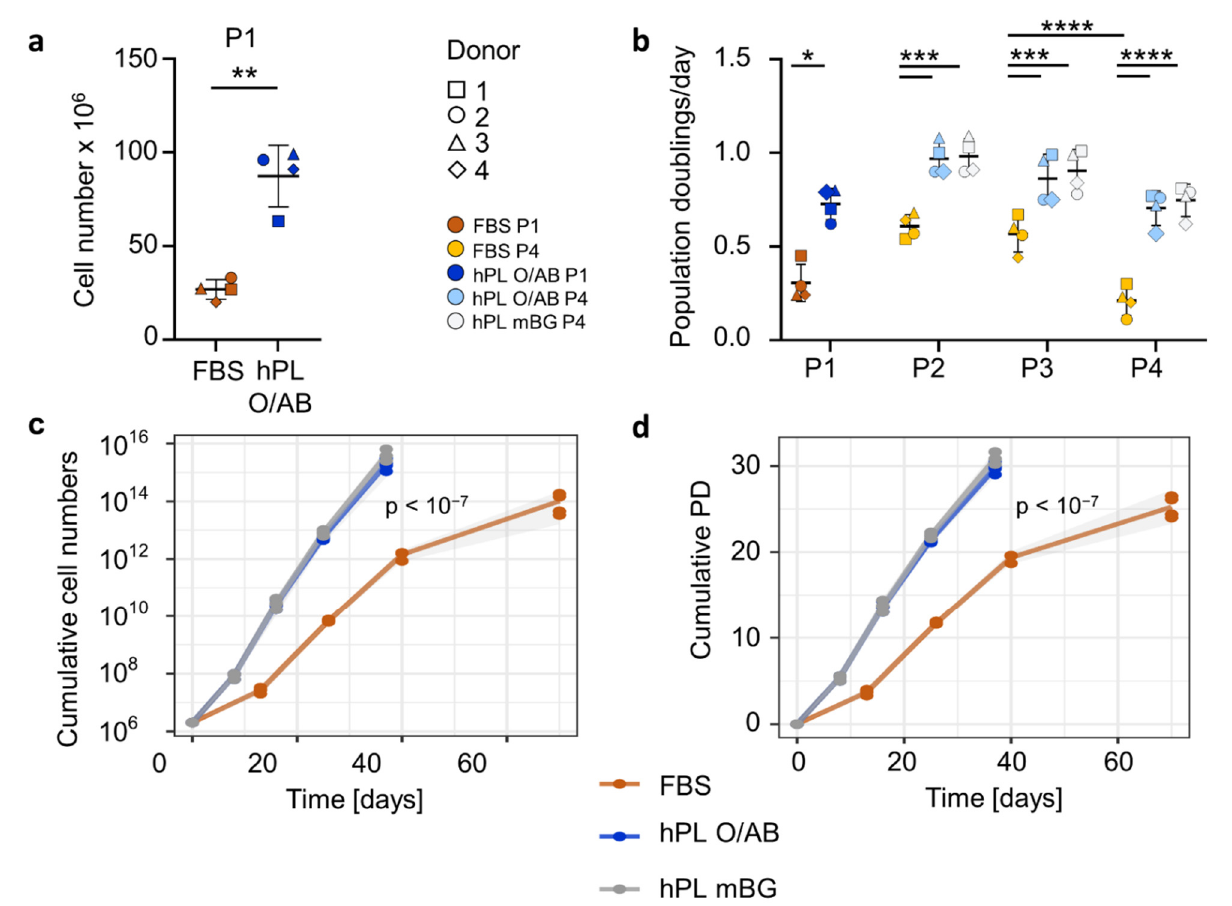
Figure A3. Large-scale extended propagation of BMSCs ( a ) Absolute number of BMSCs (donor 1–4, as indicated) cultured for one passage (P1) either with FBS or hPL O/AB. Paired t-test, ** p < 0.01. ( b ) Calculated population doublings per day of P1–P4 of BMSCs propagated in media containing FBS, hPL O/AB or hPL mBG. Repeated measures, one-way ANOVA with multiple comparisons (Tukey) p < 0.0001, p -values of multiple comparisons and t-test as depicted * < 0.5, *** < 0.001, **** < 0.0001. ( c ) Cumulative cell numbers and ( d ) cumulative population doublings of BMSCs cultured